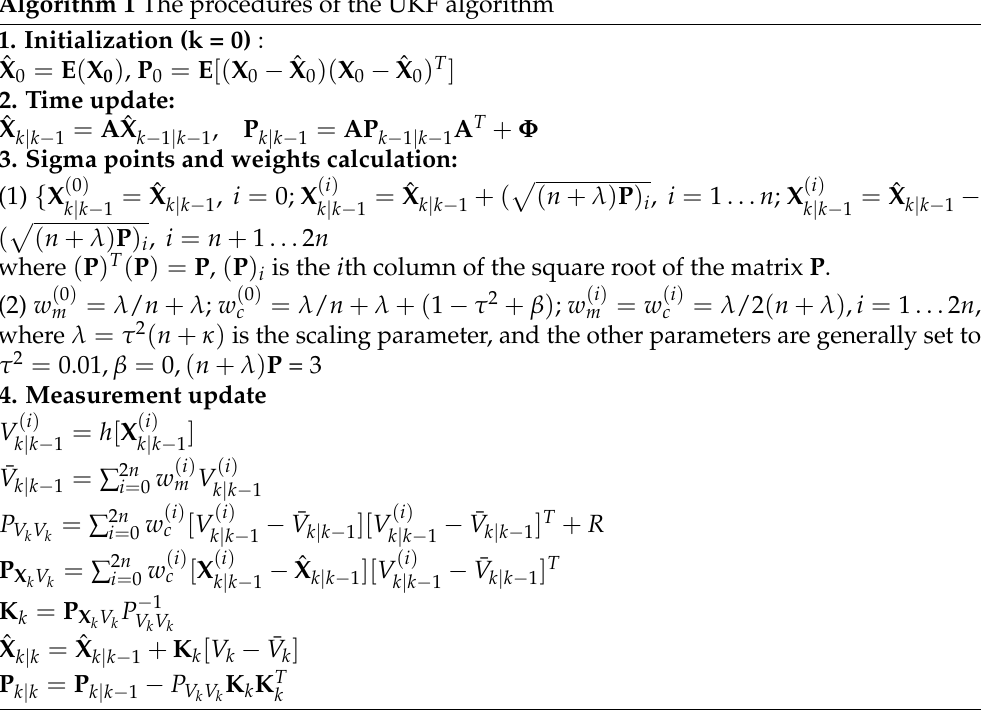
Algorithm 1 The procedures of the UKF